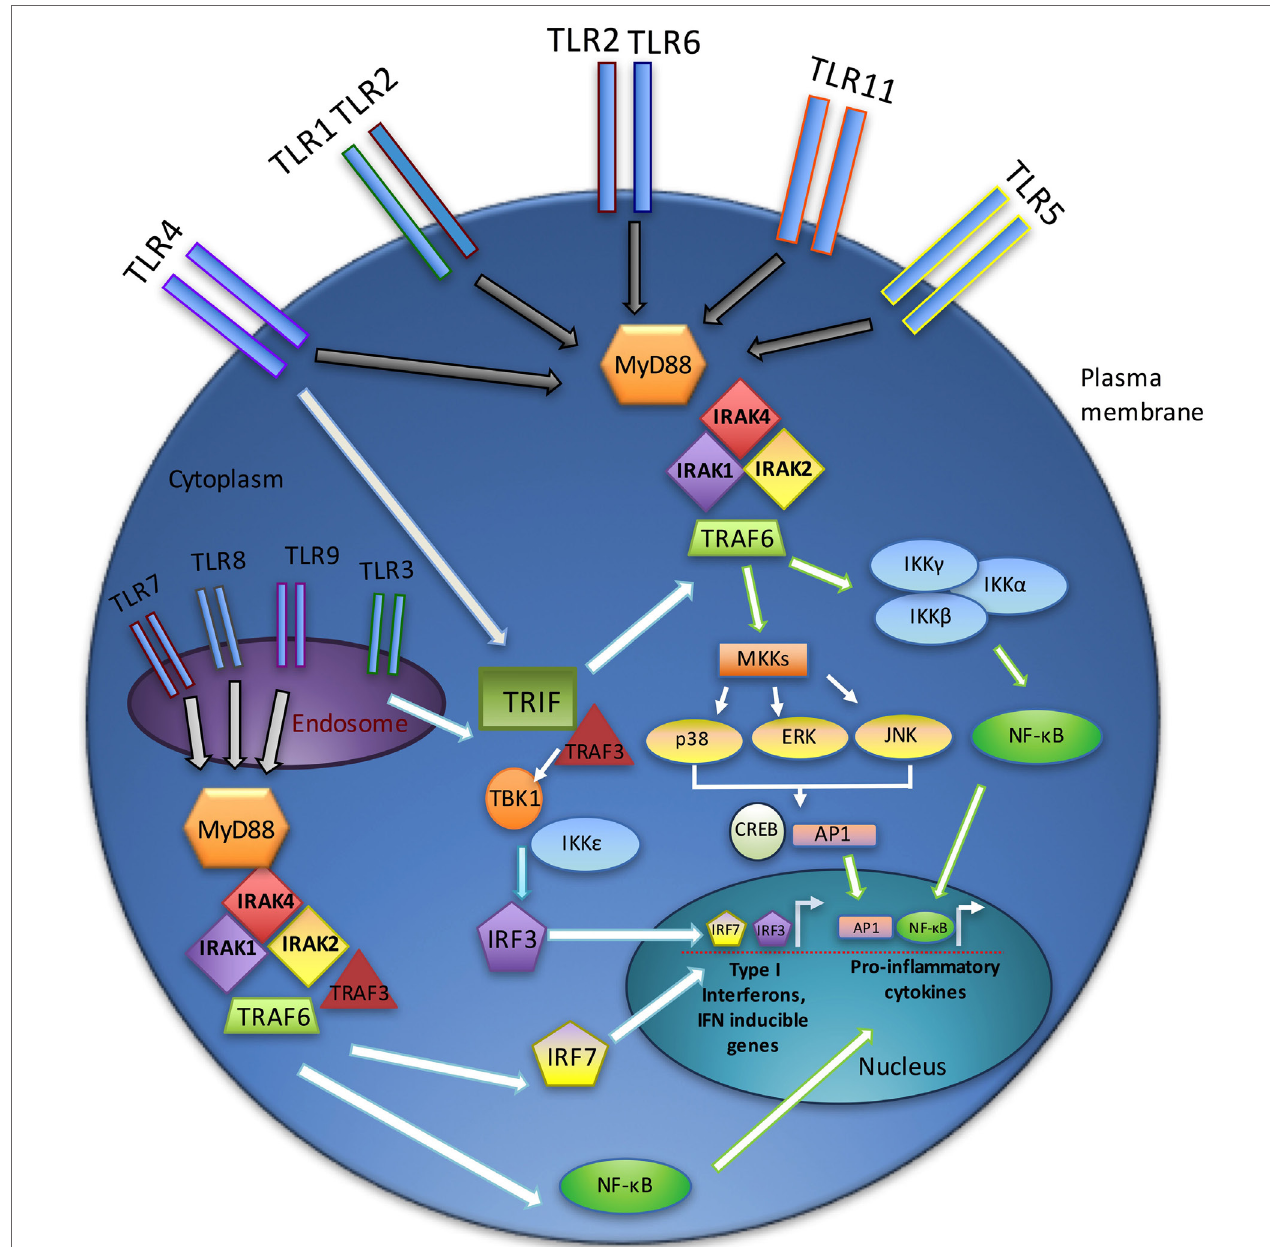
FiGURe 1 | TLR signaling overview . TLR signaling may be divided into the MyD88-dependent and MyD88-independent (TRIF-dependent) signaling pathways. In the MyD88-dependent pathway, activation of MyD88 from membrane-bound TLR ligation forms complexes with IRAKs1, 2, and 4, leading to an interaction with TRAF6. Ultimately, the NF- κ B and MAPK pathways are activated, resulting in the production of inflammatory cytokines. The TRIF-dependent (MyD88-independent) pathway requires TRIF binding to TRAF3, which recruits TBK1 and IKK ε , thereby activating IRF3. Endosomal TLRs (3, 7, 8, and 9) act through the IRAK–TRAF6 complex to activate IRF7. Together, IRF3 and IRF7 stimulate type I interferon